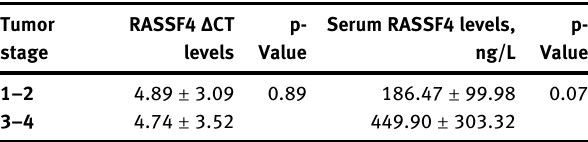
Table  : RASSF  Δ CT levels and serum RASSF  levels according to tumor